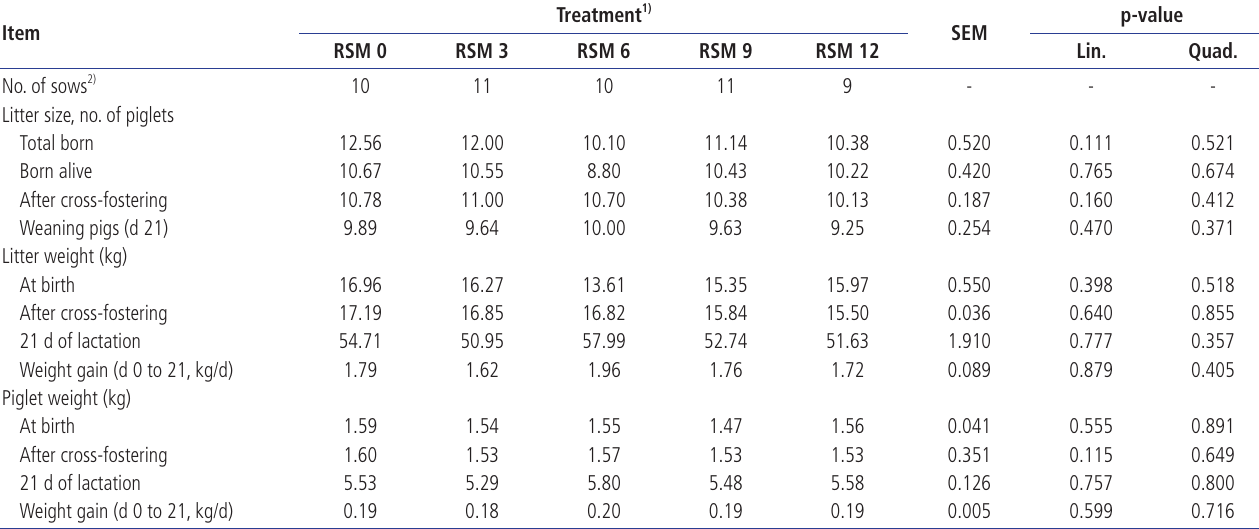
Table 5. Effect of rapeseed meal (RSM) supplementation levels in gestation diets on litter size and litter performance of